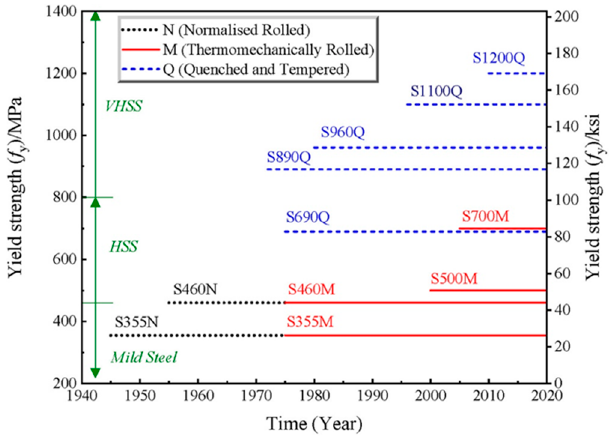
Figure 2. Development of various hot-rolled steels. Reprinted with permission from ref. [13]. Copyright 2022, Elsevier.